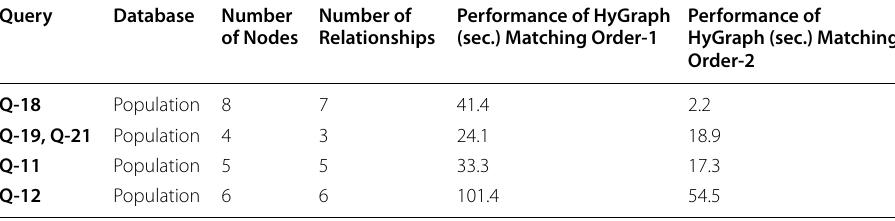
The timings are given in terms of seconds